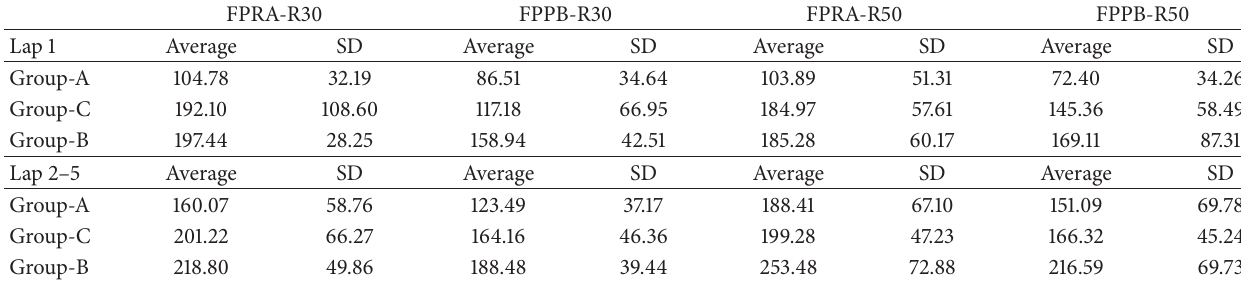
Table 1: The result of braking data of two curves.